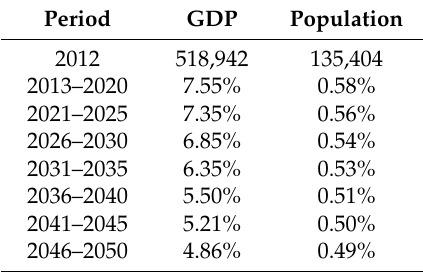
Table 2. Predicted values of China’s GDP and Population Growth Rates in